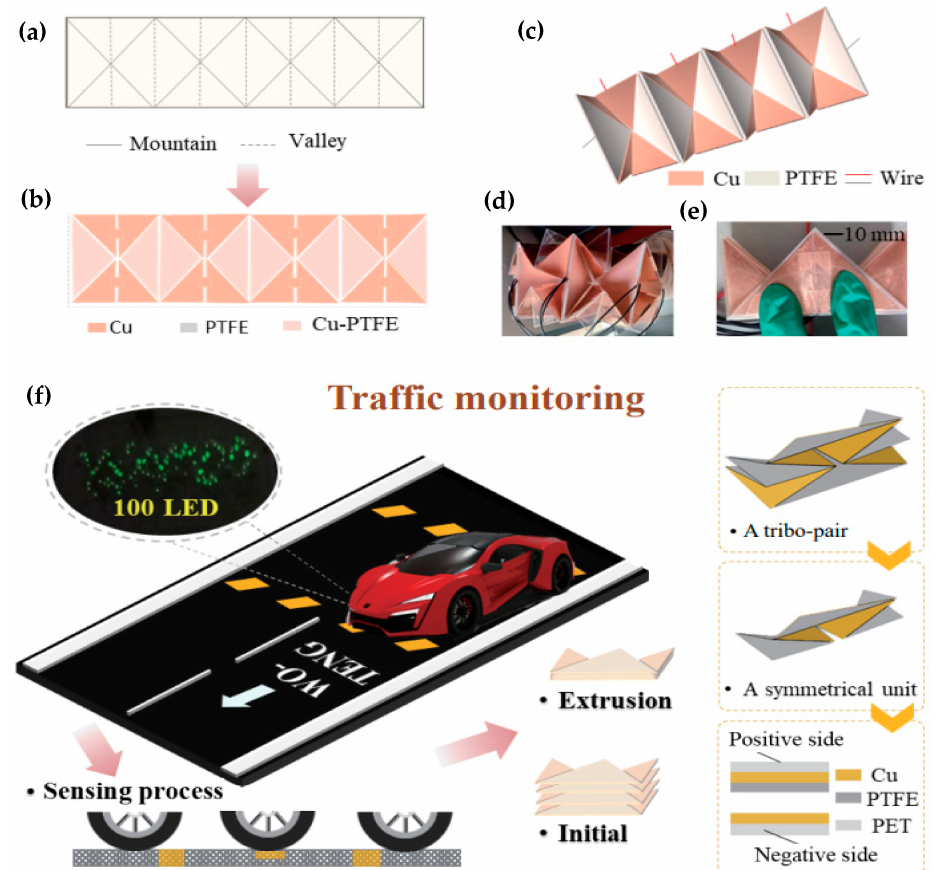
Figure 15. Waterbomb origami-based TENG: ( a ) Bidimensional schematic of the origami structure for the TENG’s PET substrate. ( b ) Bidimensional representation of the disposition of the materials constituting the tribo-couple. ( c ) Three-dimensions view of the disposition of the materials forming the tribo-couple. ( d ) WO-TENG prototype. ( e ) Folded WO-TENG. ( f ) Application of the WO-TENG to the road (Reprinted with permission from Ref. [55]. 2022, Springer Nature) [55].